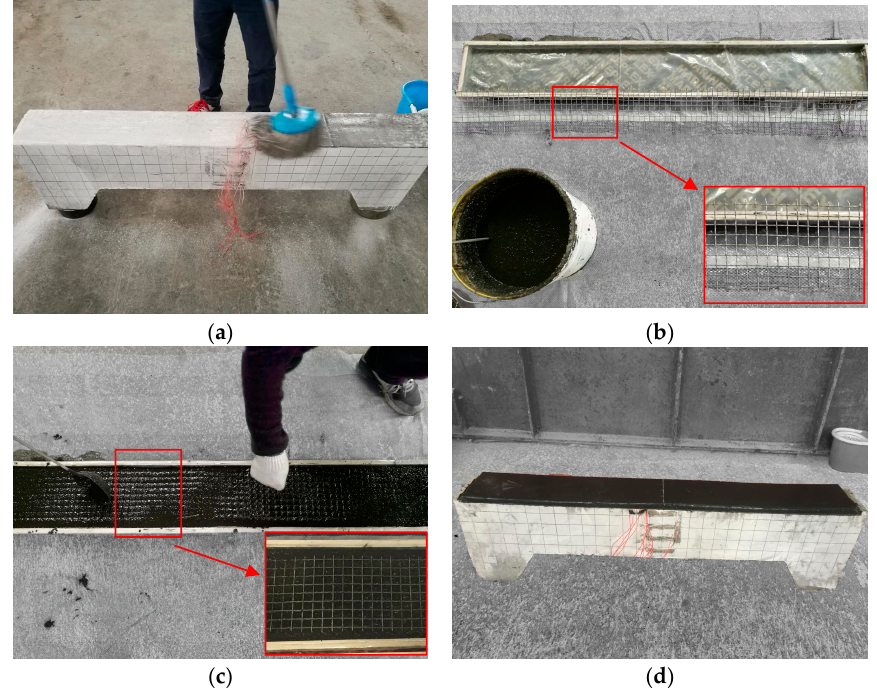
Figure 7. Reinforcement process of S specimens: ( a ) Clean and wet the surface, ( b ) install the formwork, ( c ) install the steel mesh, ( d ) cast resin concrete and demold after five days.